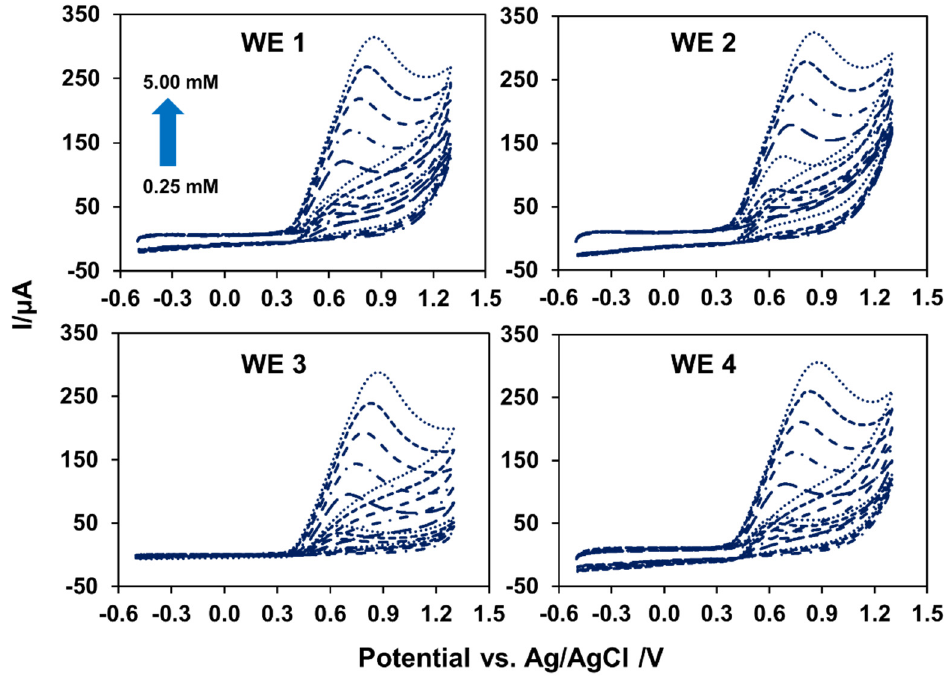
Figure 6. The CVs of nitrite obtained from four WEs on the proposed MGrEs at the same time in the concentration range of 0.25 to 5.00 mM.